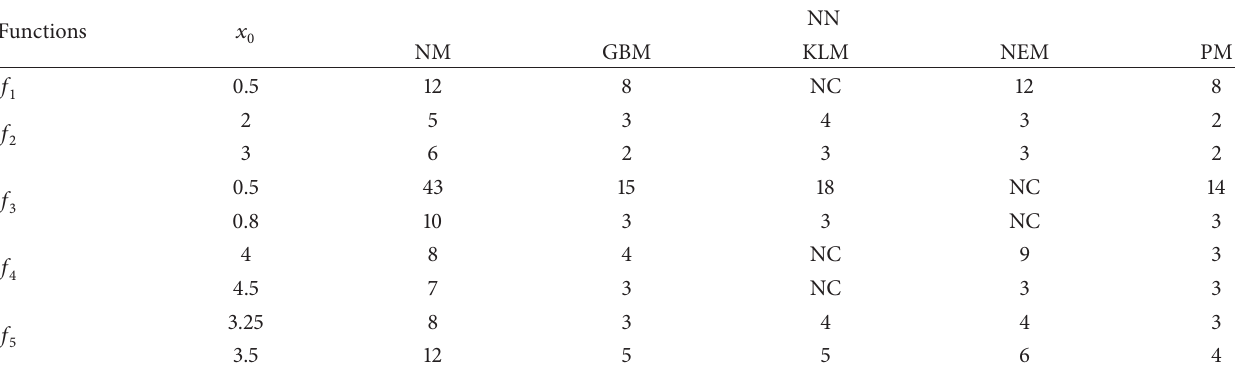
Table 1: Comparison of number of iterations